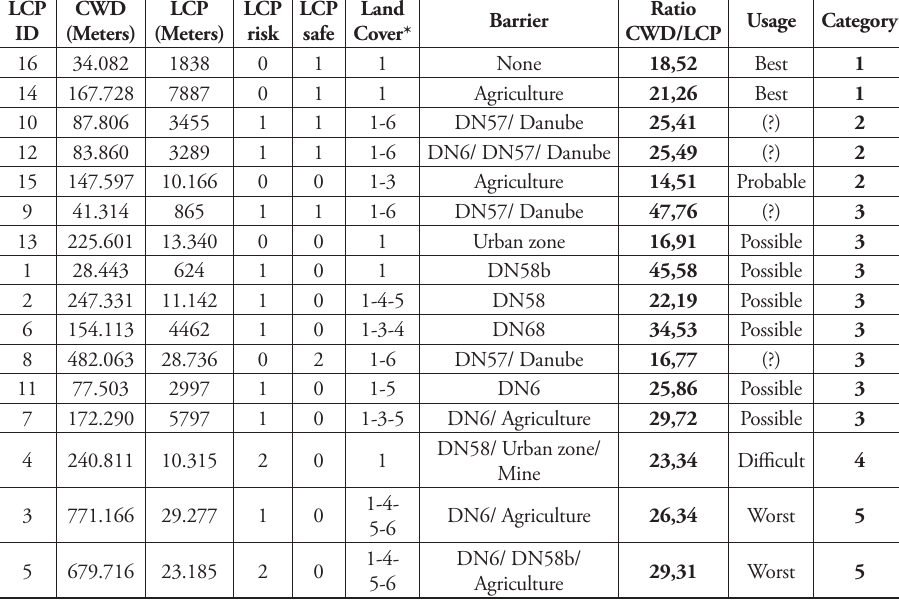
Table 3. LCPs classification for the Lynx in the Pilot Area Djerdap/Iron